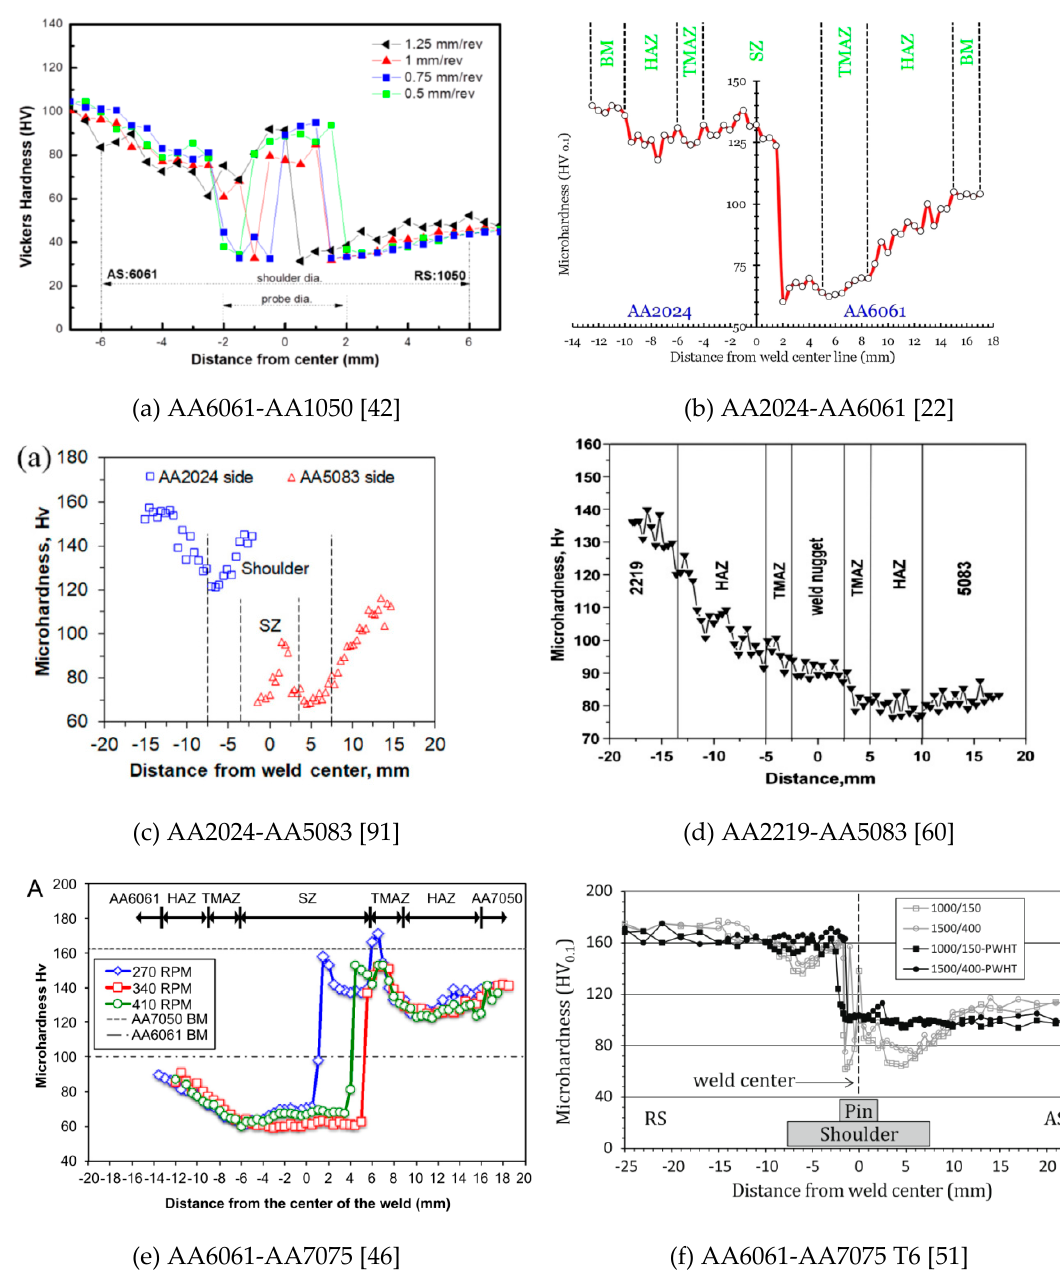
Figure 10. Hardness distribution along the cross section of the dissimilar Al combination joints. ( a ) AA6061-AA1050 [42]; with permission from the authors. ( b ) AA2024-AA6061, reproduced from [22], with permission from Elsevier, 2108; ( c ) AA2024-AA5083 reproduced from [91], with permission from Elsevier, 2019; ( d ) AA2219-AA5083 reproduced from [60], with permission from Elsevier, 2012; ( e ) AA6061-AA7075 reproduced from [46], with permission from Elsevier, 2015; ( f ) AA6061-AA7075 T6], reproduced from [51], with permission from Springer, 2014.